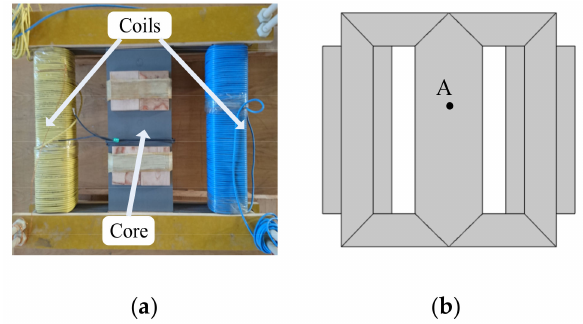
Figure 9. Three-limb laminated core: ( a ) Practical model; ( b ) simulated model.